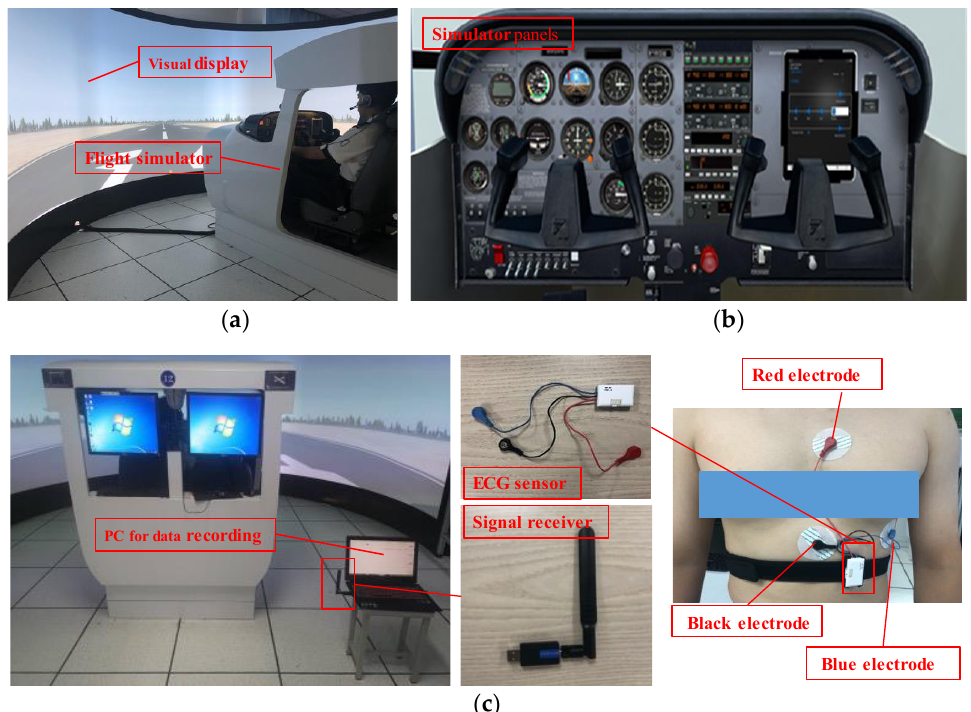
Figure 5. Flight simulation experiment equipment. ( a ) Cessna 172 flight simulator. ( b ) Simulator panels of Cessna 172 flight simulator. ( c ) The wireless wearable ECG data acquisition and recording device. Table 5. Parameters of wireless wearable ECG sensor.